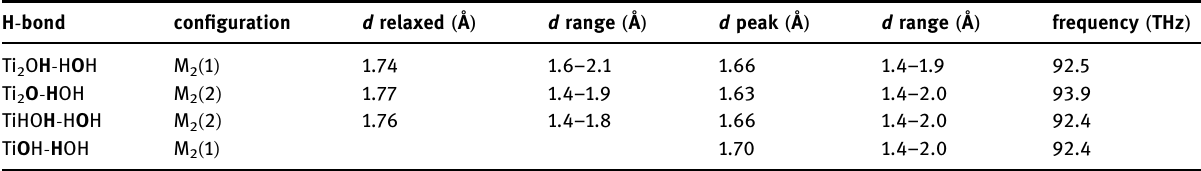
Table 1: Characteristics of the strongest hydrogen bonds in the H 2 O/TiO 2 interface H -